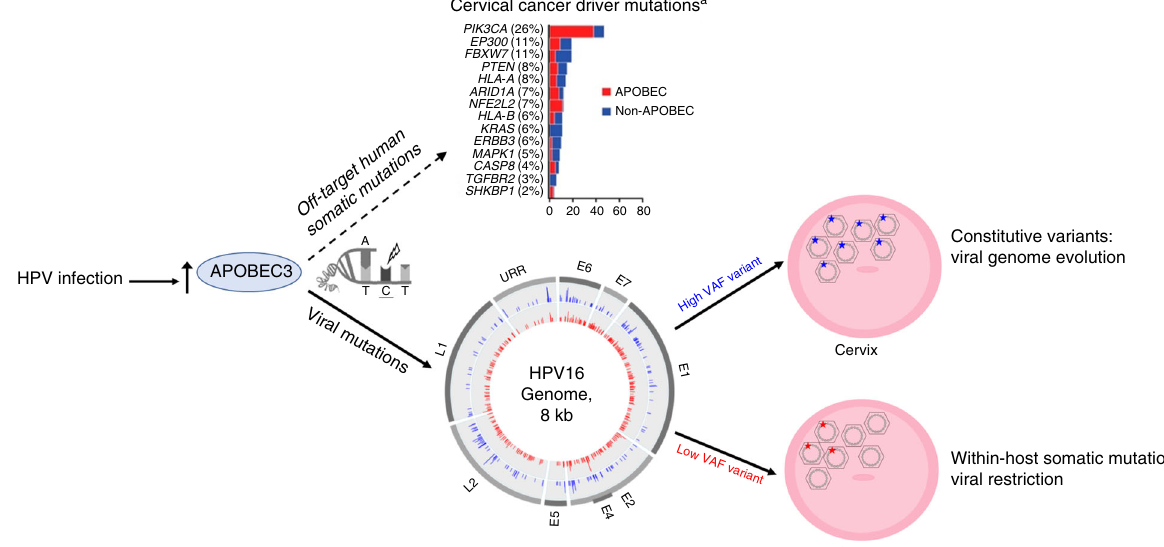
Fig. 4 Summary of the effects of mutations induced by the activity of APOBEC3. Viral APOBEC3-induced mutations are illustrated in the circle plot by viral gene region in the inner ring for low variant allele fraction (VAF) somatic mutations in red, and the outer ring for high VAF constitutive variants in blue for all individuals in the PaP cohort (mutations in both cases and controls are illustrated). Modi fi ed from the Cancer Genome Atlas Research Network 35